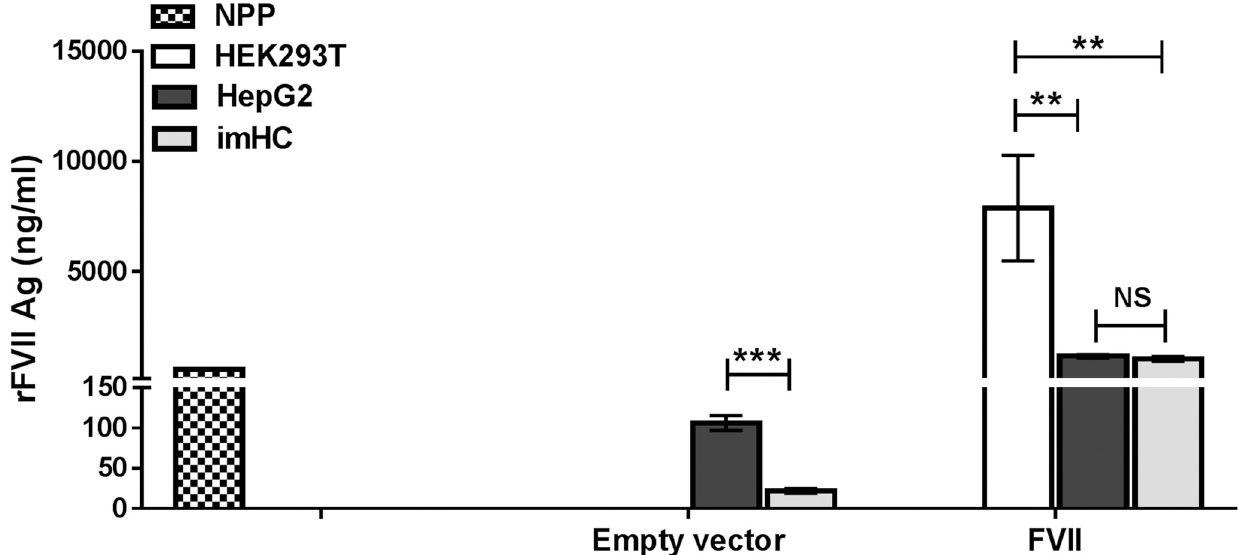
Fig 2. FVII levels secreted in culture media supernatant. Cell lines were transduced with the indicated lentivirus, and FVII levels in culture supernatant were determined by ELISA. Normal pooled plasma (NPP) was used as a positive control. Data are reported as mean ± SEM (n = 3). There was a significant difference in FVII level between Empty vector- HepG2 vs Empty vector- imHC (p = 0.0005), FVII-HEK293T vs FVII-HepG2 (p = 0.0042), and FVII-HEK293T vs FVII-imHC (p = 0.0036). No significant difference was observed in FVII-HepG2 vs FVII-imHC (p > 0.9999). Statistical differences were analyzed with paired student t -test for Empty vector- HepG2 vs Empty vector- imHC and one-way ANOVA test for FVII-HEK293T vs FVII-HepG2, and FVII-HEK293T vs FVII-imHC (p = 0.0036). �� ; p < 0.01, ��� ; p < 0.001.